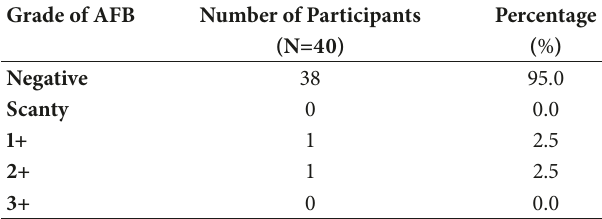
Table 3: Grading of AFB in smears using fluorescent microscopy.